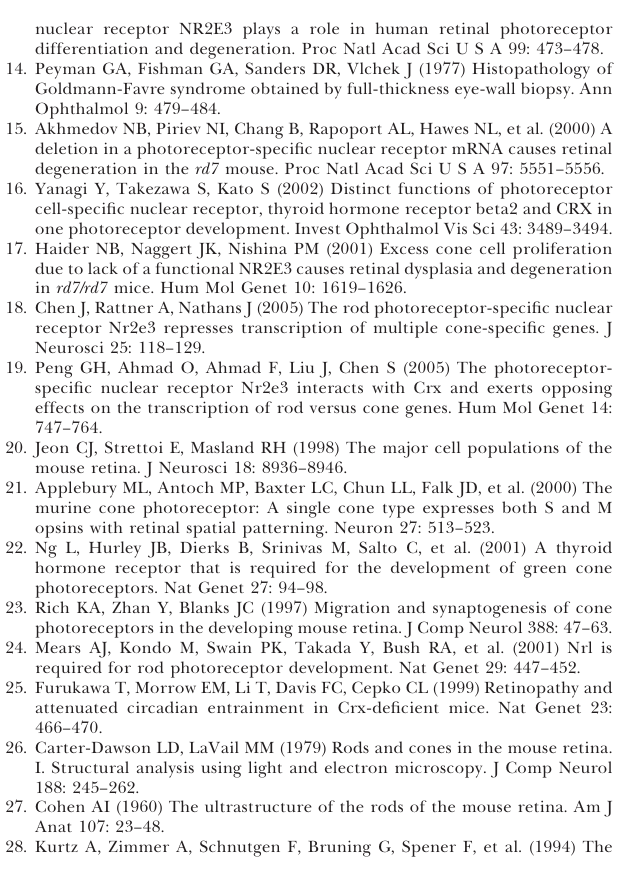
Table S5. Summary of Genes Down-Regulated in rd7 Mutant Retina at P21 by Affymetrix Microarray Only genes that were found to be down-regulated in three out of three microarray experiments (as described in Materials and Methods) are listed. ‘‘ Nr2e3 signal ’’ and ‘‘ C57BL/6 signal ’’ represent the average signal for that transcript in all three microarray experiments. Table S6. Raw cDNA Microarray Data for rd7 versus Wild-Type Comparison at P0 (I) Found at DOI: 10.1371/journal.pgen.0010011.st006 (5.6 MB XLS). Table S7. Raw cDNA Microarray Data for rd7 versus Wild-Type Comparison at P0 (II) Found at DOI: 10.1371/journal.pgen.0010011.st007 (5.6 MB XLS). Table S8. Raw cDNA Microarray Data for rd7 versus Wild-Type Comparison at P0 (III) Found at DOI: 10.1371/journal.pgen.0010011.st008 (5.6 MB XLS). Table S9. Raw cDNA Microarray Data for rd7 versus Wild-Type Comparison at P6 (I) Found at DOI: 10.1371/journal.pgen.0010011.st009 (5.6 MB XLS). Table S10. Raw cDNA Microarray Data for rd7 versus Wild-Type Comparison at P6 (II) Found at DOI: 10.1371/journal.pgen.0010011.st010 (5.6 MB XLS). Table S11. Raw cDNA Microarray Data for rd7 versus Wild-Type Comparison at P6 (III) Found at DOI: 10.1371/journal.pgen.0010011.st011 (5.6 MB XLS). Table S12. Raw cDNA Microarray Data for rd7 versus Wild-Type Comparison at P14 (I) Found at DOI: 10.1371/journal.pgen.0010011.st012 (5.5 MB XLS).